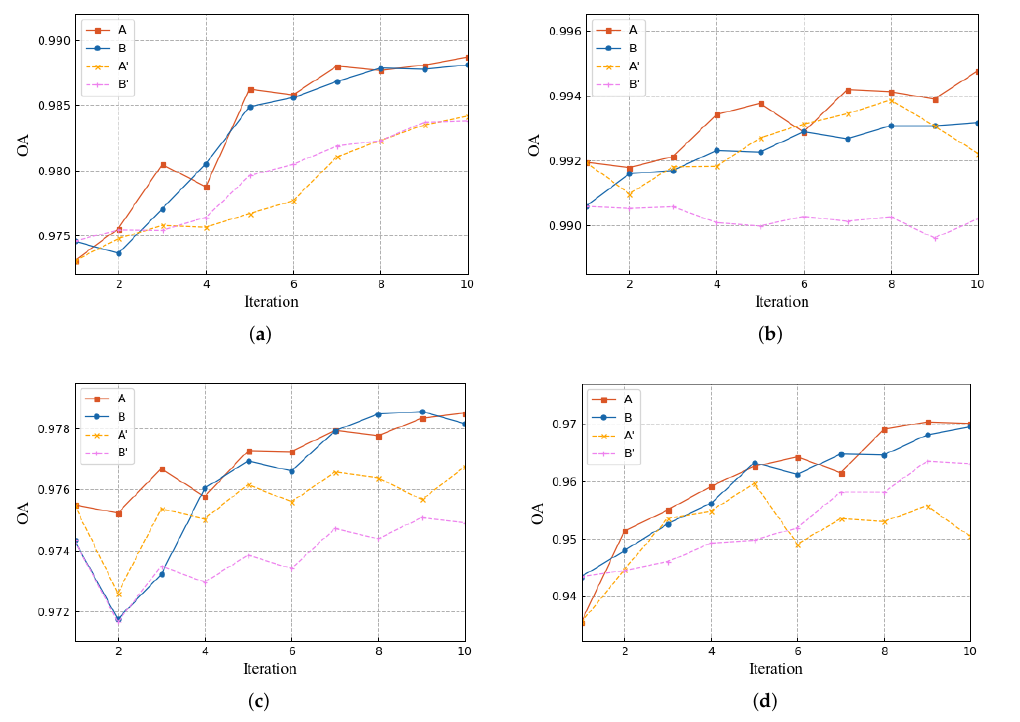
Figure 10. The iterative performance of the mutual teaching framework, where A and B use mutual teaching and A (cid:48) and B (cid:48) are self-training. ( a ) Bastrop dataset. ( b ) Umatilla dataset. ( c ) Yancheng dataset. ( d ) River dataset.